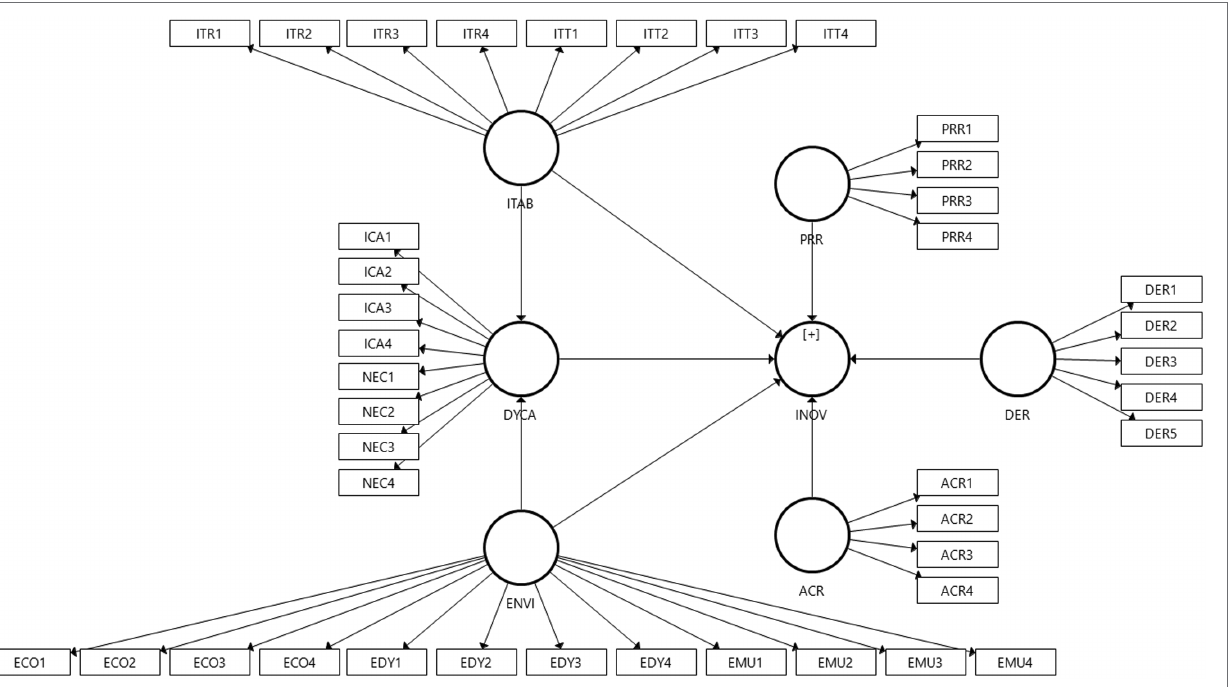
FIGURE 1 | Conceptual